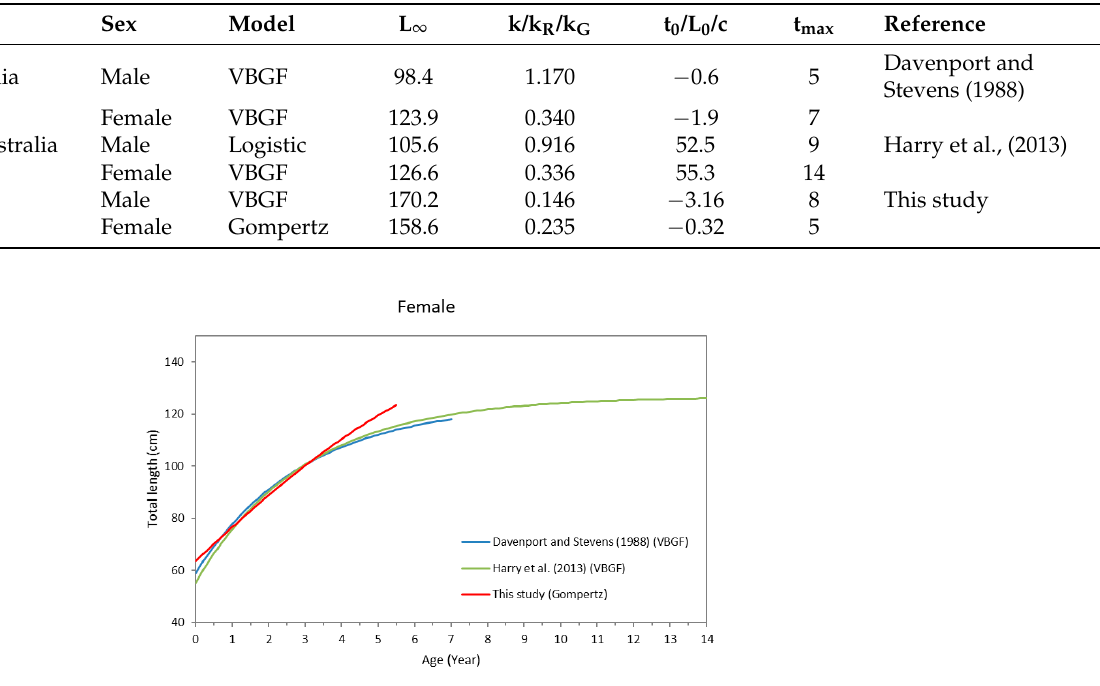
Figure 7. Comparison of the growth curves of female spot-tail sharks in different regions. VBGF: Davenport and Stevens (1988) and Harry et al. (2013); Gompertz: this study.